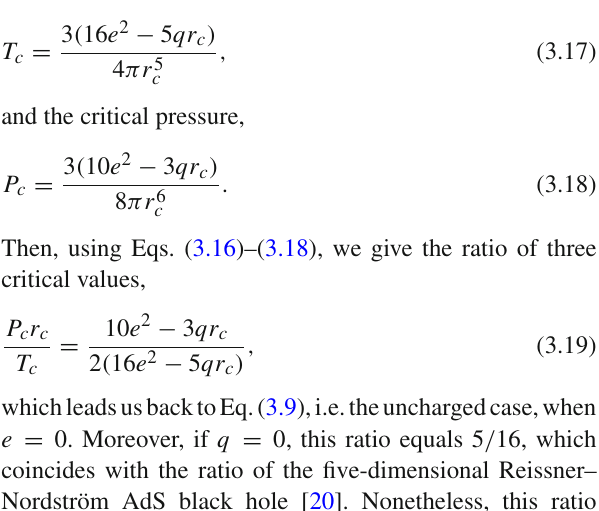
each other. Both of them terminate at the critical point,